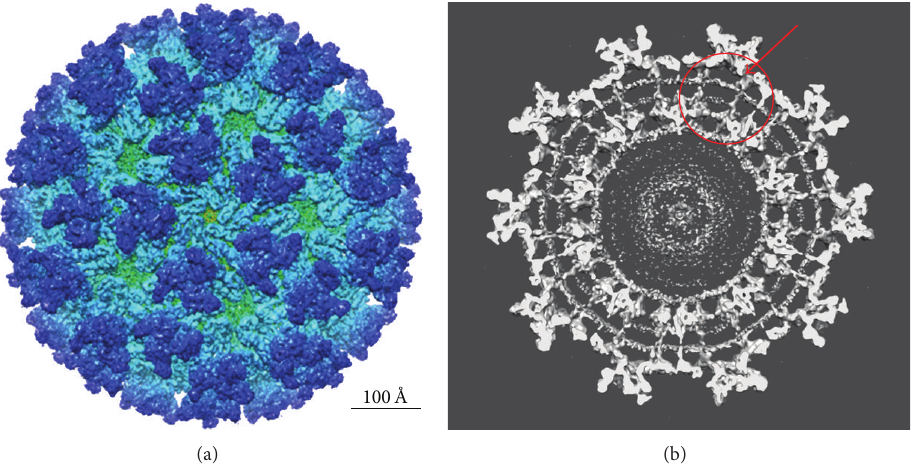
Figure 1: Shown in (a) is the cryo-EM reconstruction of the TC-83 strain of Venezuelan equine encephalitis virus (VEE) viewed down the strict 5-fold axis. Resolution is 4.4 ˚A. The trimers consist primarily of E2 with the smoother “skirt” comprised of E1. In (b) is shown a slice down the 2-fold axis. Note the transmembrane domains (arrow) and the extensive organization of the nucleocapsid (circle) compared to that seen in the flaviviruses (Figure 3(b)). With permission from Zhang et al. [22]. For full resolution images see EM DATA BANK (EMDB)/5275.